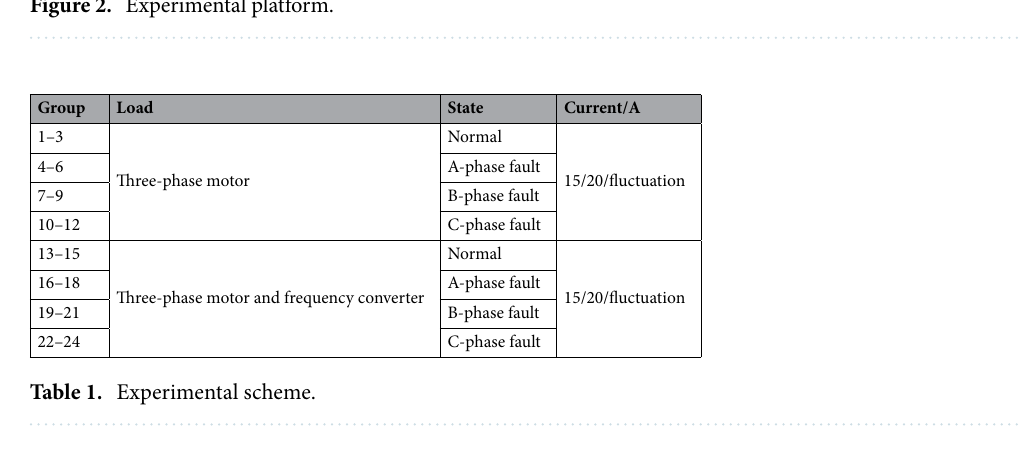
Figure 2. Experimental platform.